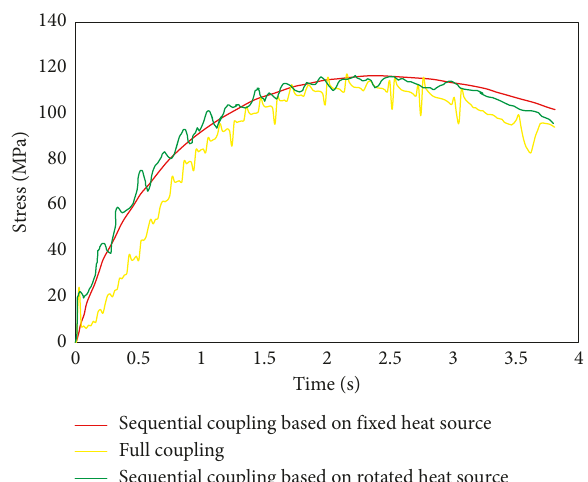
Figure 15: Comparison of three simulation methods for the stress change curve.